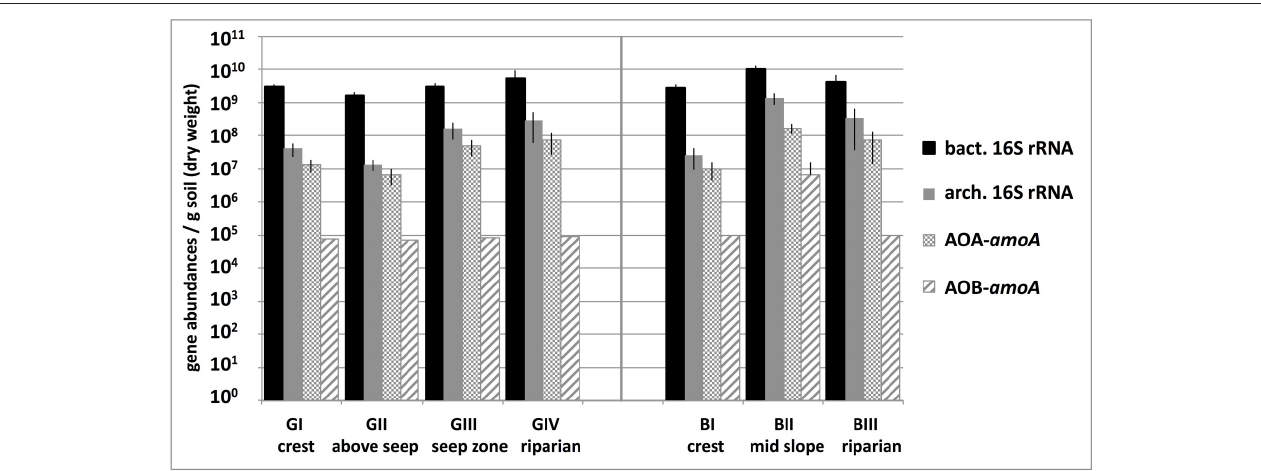
FIGURE 2 | Abundances of bacterial and archaeal 16S rRNA genes and archaeal and bacterial amoA genes (AOA- amoA , AOB- amoA ) per gram soil in savanna soil samples taken from 5 cm depth at different locations along the granitic (GI-GIV) and the basaltic (BI-BIII) catena. Bars represent mean abundances of replicate samples, each measured in triplicate qPCR reactions, and respective standard deviations. Abundances of bacterial amoA genes were below the quantification limit (50 genes per qPCR reaction) in all samples except BII and maximum estimates based on this limit are